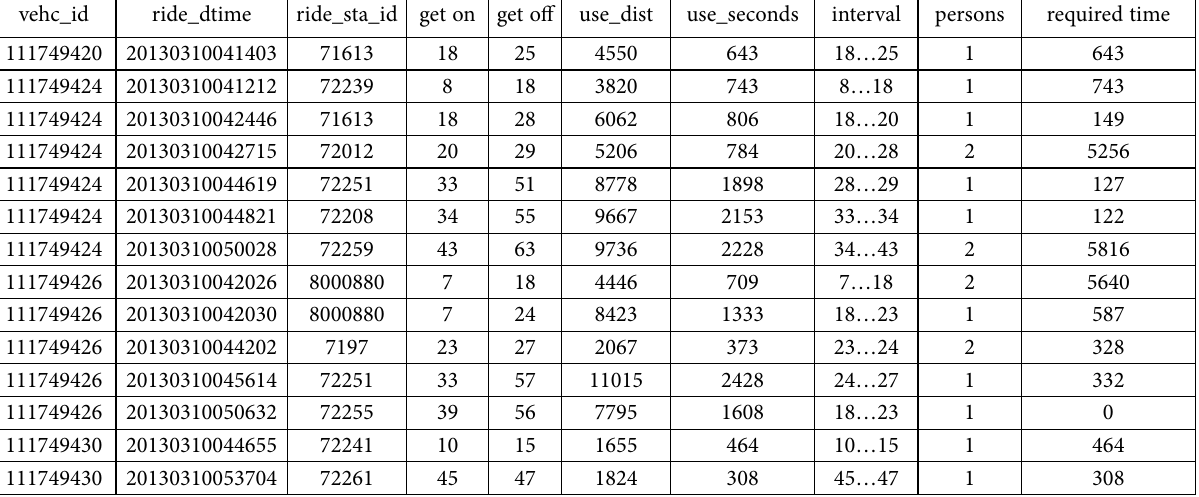
Table 4. Smart card data after